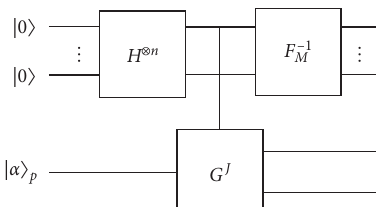
M represents the